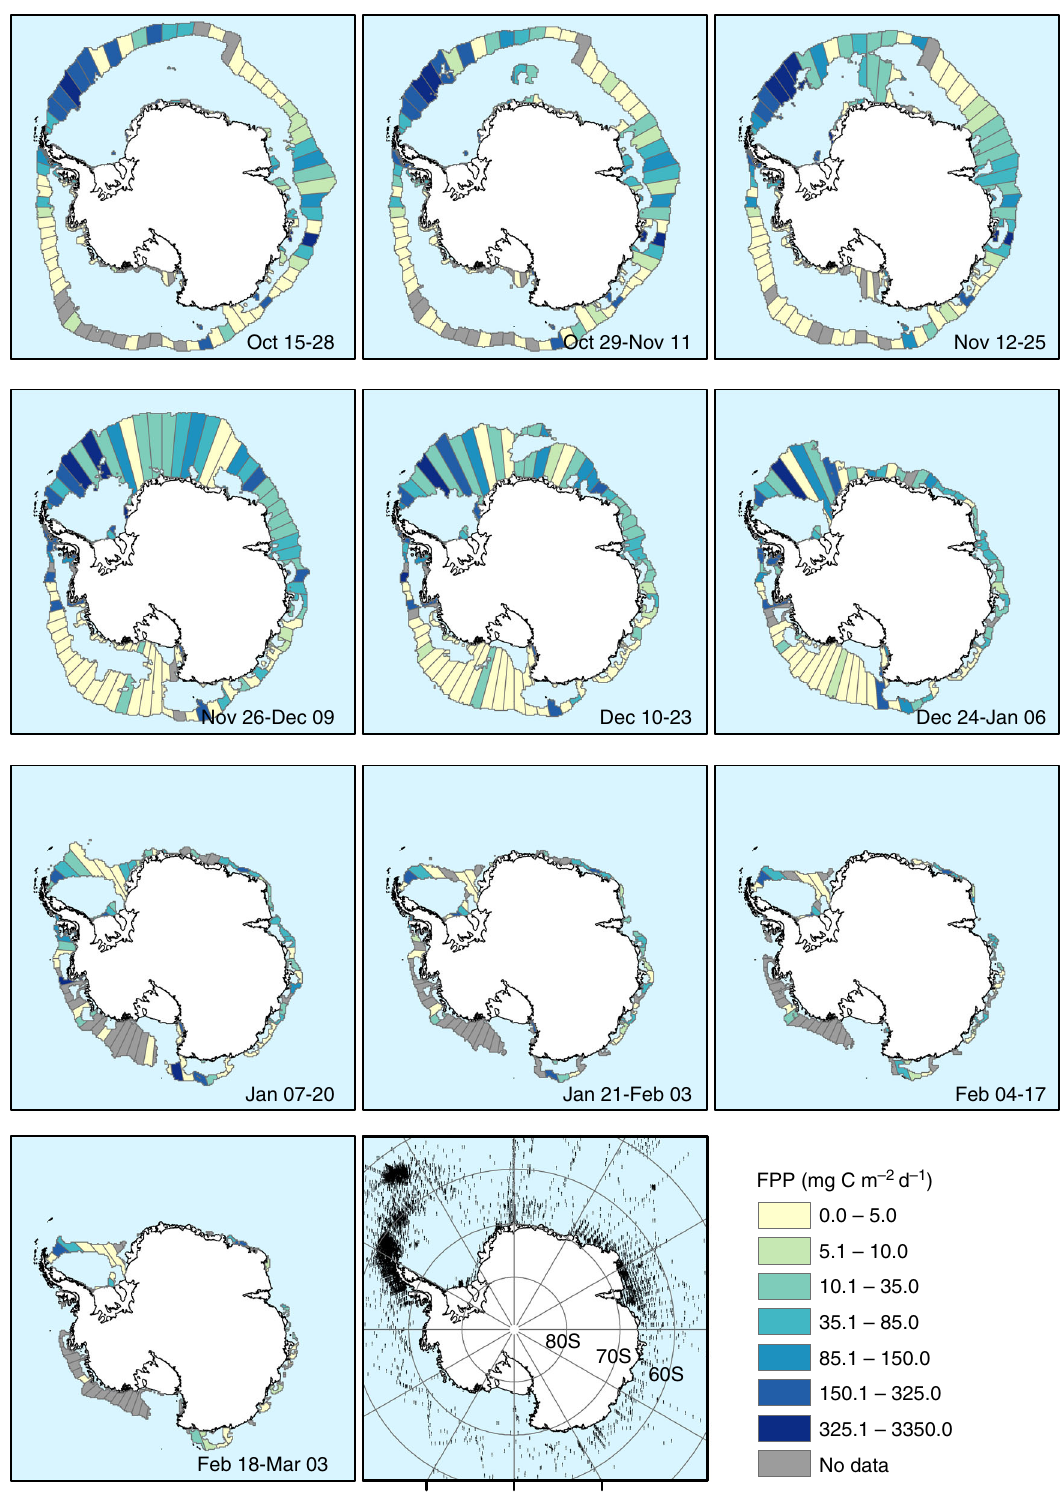
Fig. 1 Estimated krill faecal pellet production (FPP) in the marginal ice zone, Antarctica. The marginal ice zone, from fortnightly sea ice concentration data (15 – 80% ice cover), is divided into 5 ° zonal cells, and is coloured by FPP (mg C m − 2 d − 1 ) based on krill density measurements from KRILLBASE (black dots) and literature krill FP production rates. Regions of the marginal ice zone where no KRILLBASE records occurred are coloured in grey. The Antarctic coastline was obtained from the SCAR Antarctic Digital